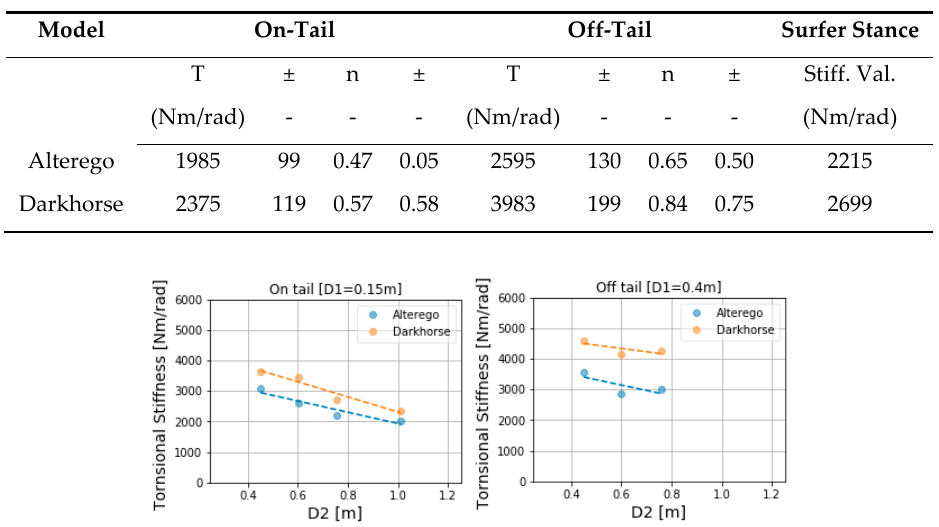
Table 2. Results from the torsional stiffness test. T, n and ± indicate the torsional stiffness index, stiffness coefficient and standard deviation values, respectively.